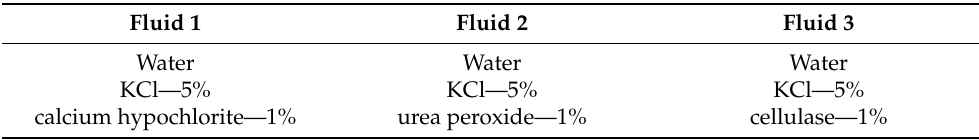
Table 7. Selected fluid compositions for eroding filter cakes produced from drilling mud taken from the K-1